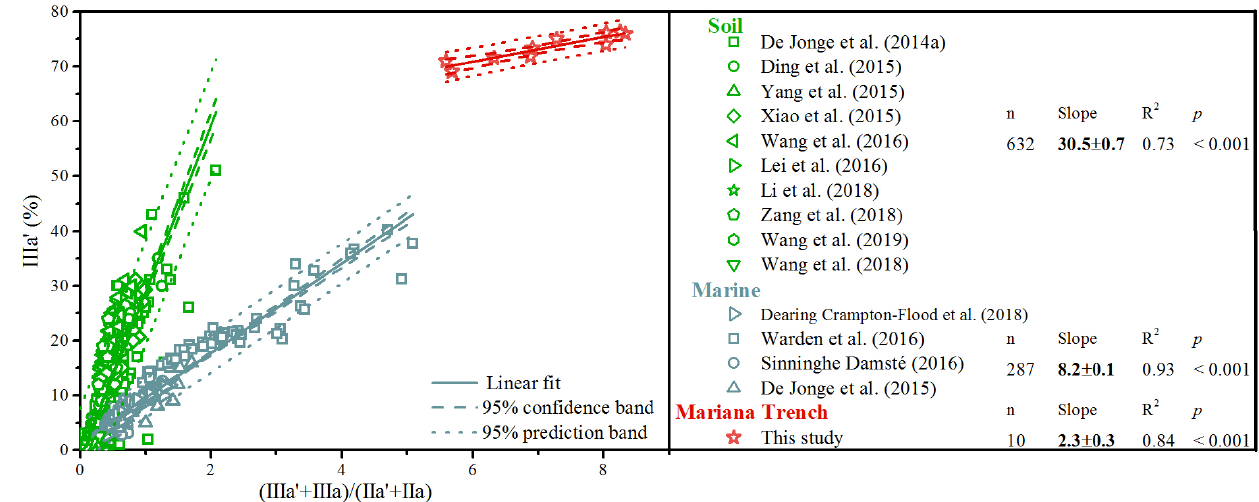
Figure 9. Scatterplots of the ( IIIa + IIIa (cid:48) )/( IIa + IIa (cid:48) ) ratio versus the proportion of brGDGT IIIa (cid:48) in globally distributed soils and marine sediments. The solid, dashed, and dotted lines denote the linear fit, 95% confidence band, and 95% prediction band of concatenated data, respectively. The number of samples, slope, R 2 , and p values of calibration are for the global distributed soils, marine sediments, and Mariana Trench